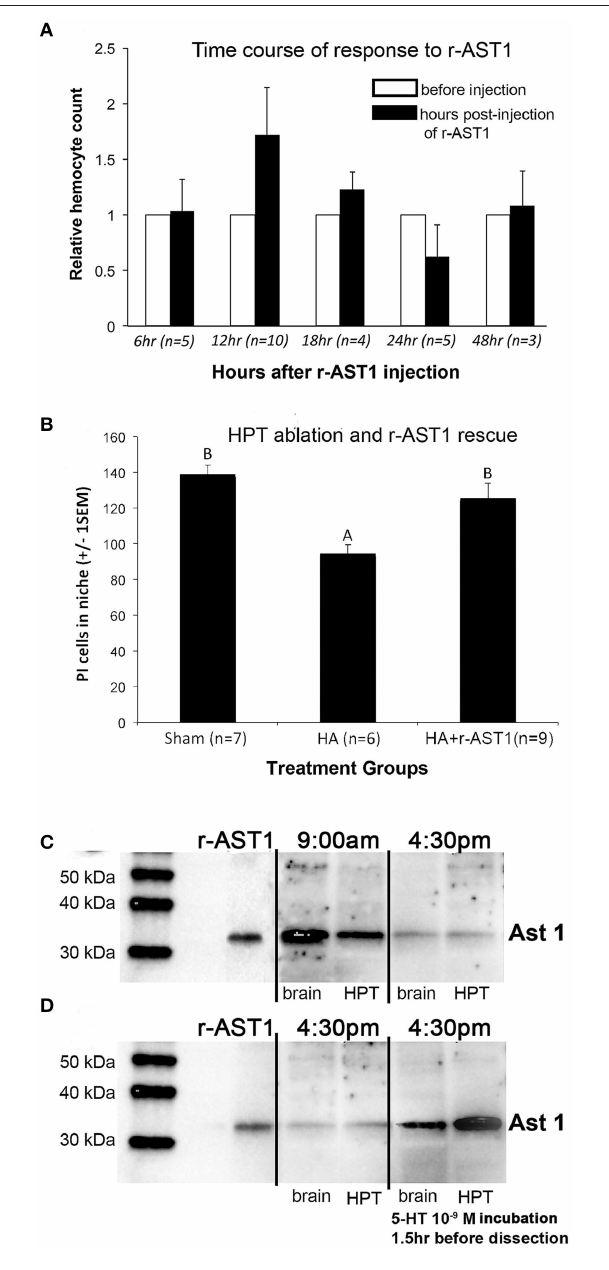
FIGURE 5 | Astakine 1: Effects on hemocyte release and the neurogenic niche, and regulation by time of day and serotonin. (A) Time course of release of hemocytes after r-AST1 injection into P. clarkii . The relative hemocyte count was calculated as the total hemocyte count (THC) at each time point divided by THC prior to r-AST1 injection. The greatest release of hemocytes occurs 12h after r-AST1 injection ( p = 0.0002). (B) Crayfish in which hematopoietic tissues were partially ablated (HA) have a significantly lower total number of niche cells (propidium iodide [PI]-labeled) compared to shams (ANOVA, F = 2.19, p < 0.002). Injection of r-AST1 into HA crayfish 48h prior to sacrifice (HA + r-AST1) restores the niche cell counts to sham values. (C) Western blot of P. clarkii AST1 and P. leniusculus r-AST1 at 9a.m. and 4:30 p.m., showing that AST1 expression varies depending on time of day, with higher expression in the morning as previously reported for P. leniusculus (Watthanasurorot et al., 2011). (D) After serotonin (10 − 9 M) incubation, the 4:30 p.m. expression of AST1 increases. A, B published in Benton et al.